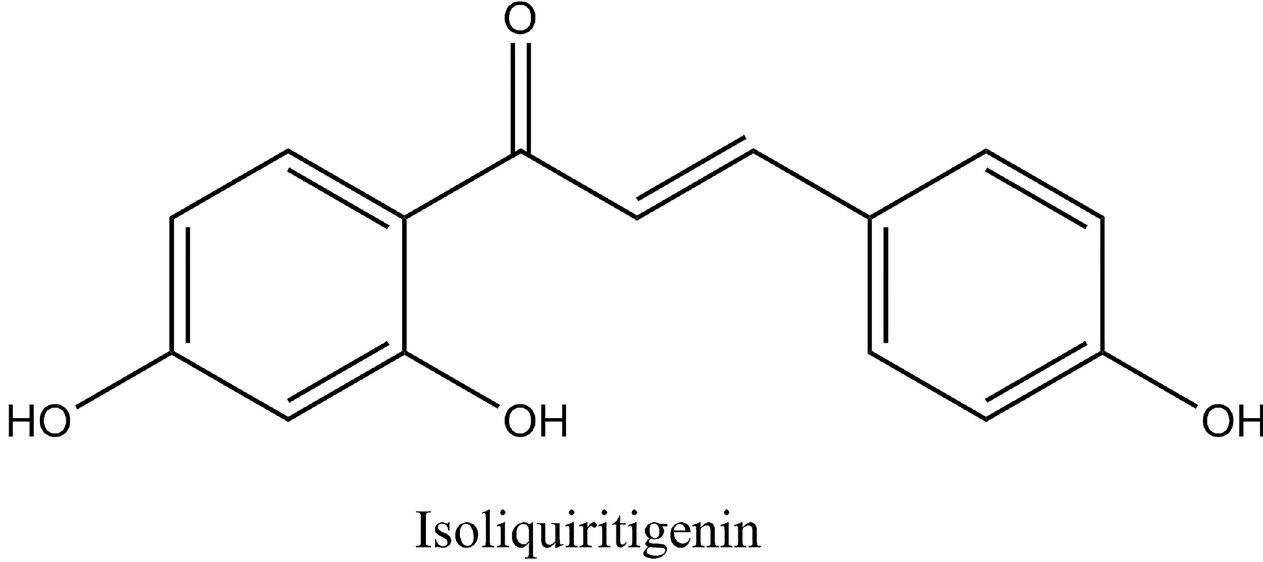
Fig 1. The chemical structure of